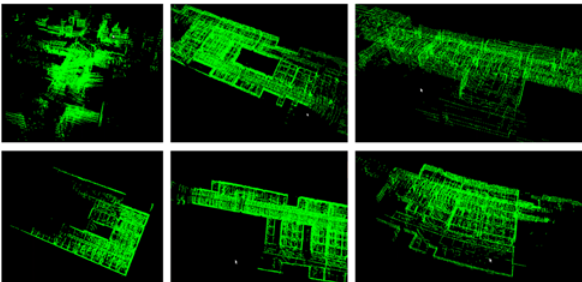
Figure 9. The aligned point cloud